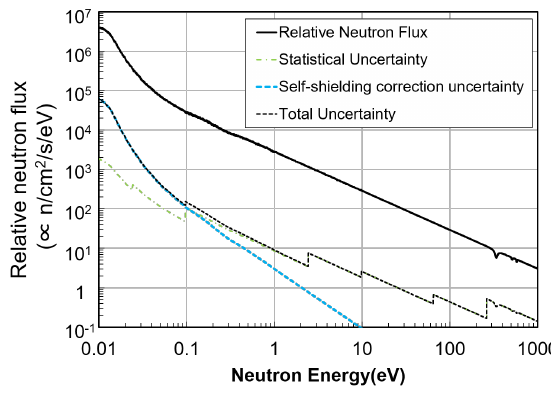
Figure 7. Relative incident neutron energy spectrum determined by measuring the 478 keV gamma rays from the 10 B(n, αγ ) 7 Li